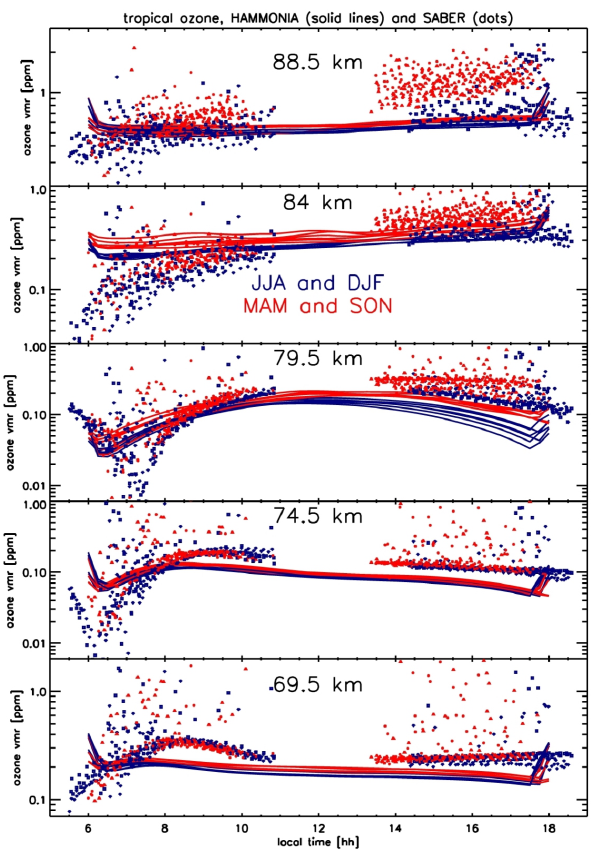
Fig. 3. SABER (dots) and HAMMONIA (solid lines) daytime ozone (1.27µm retrieval) variations at 69.5, 74.5, 79.5, 84, and 88.5km (i.e. 0.03, 0.02, 0.01, 0.0061, and 0.003hPa) sorted by month (20 ◦ S and 20 ◦ N). Months close to equinox are highlighted in red and months close to solstice are marked in